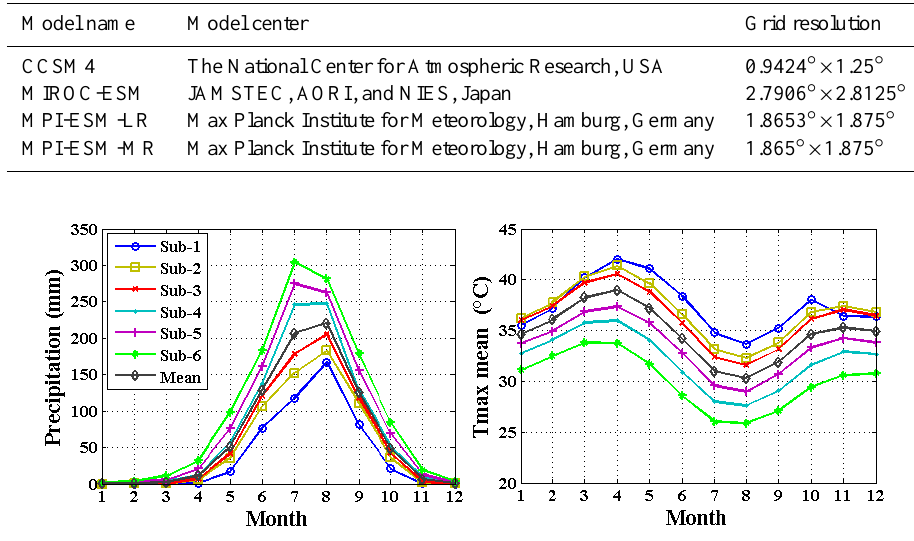
Figure 3. The mean monthly rainfall and T max regimes of all the climate stations used in this study for the period of